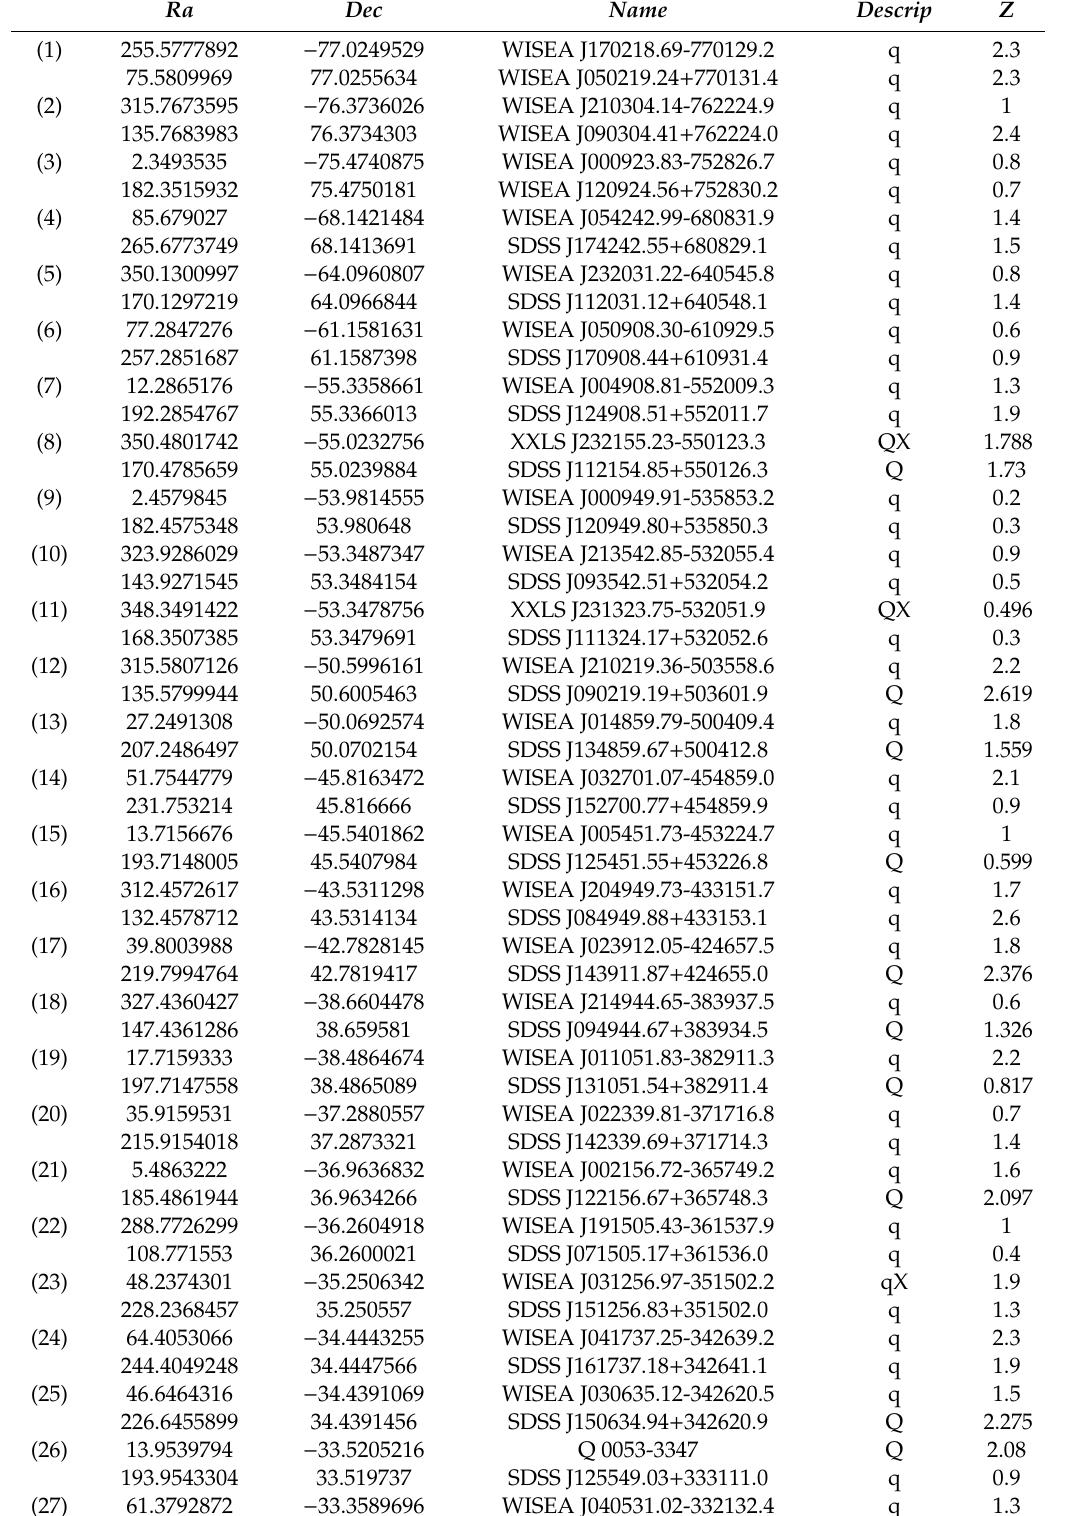
Table A15. Pairs of opposite quasars from the Milliquas 6.3 catalog for the cosmic mirror e ff ect— alternative approach. Accuracy is of 0.001 ◦ for ra and dec and z / 2 for redshift z . Descrip column is the classification of object, see